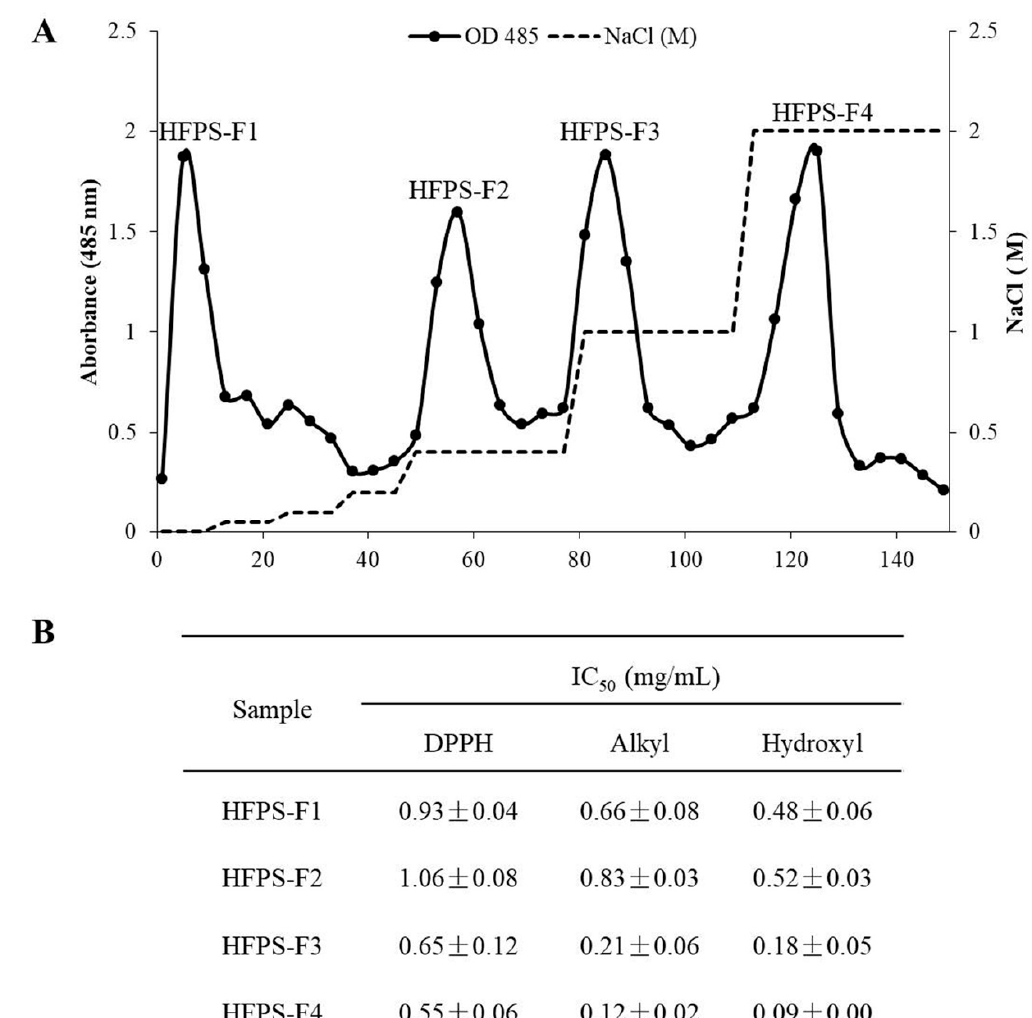
Figure 1. Isolation of polysaccharides from the crude sulfated polysaccharides of H. fusiforme (HFPS) and evaluation of their antioxidant activities. ( A ) The DEAE-cellulose chromatogram of the HFPS; ( B ) the free radical scavenging activities of polysaccharides isolated from HFPS. The experiments were conducted in triplicate, and the data are expressed as the mean ± standard error (SE).